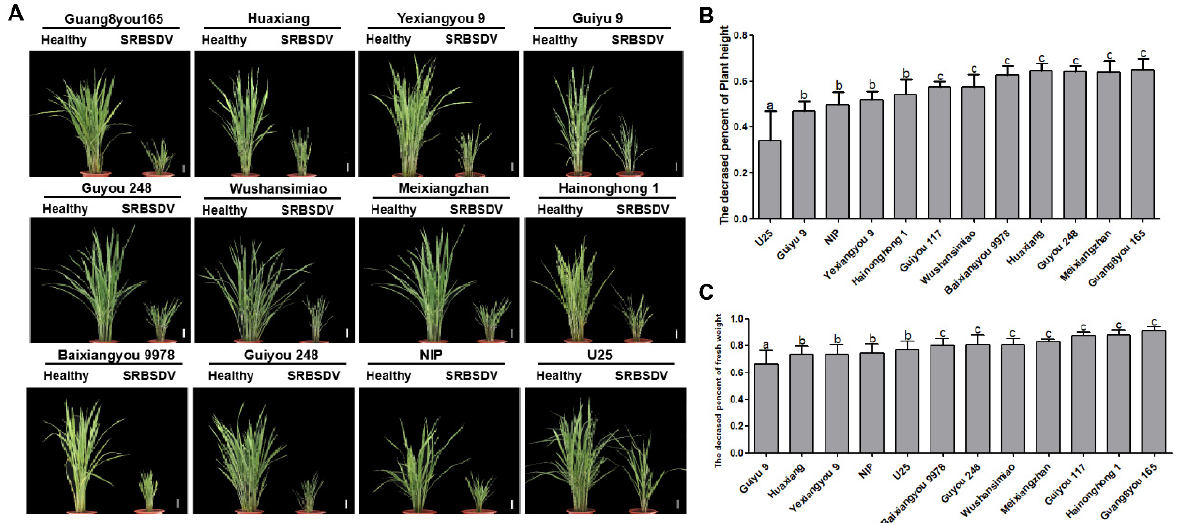
Figure 3. Symptoms ( A ), dwarfing rates ( B ), and weight loss rates ( C ) of plants at 45 days post-infection with SRBSDV. Lowercase letters indicate significant differences ( p < 0.05).